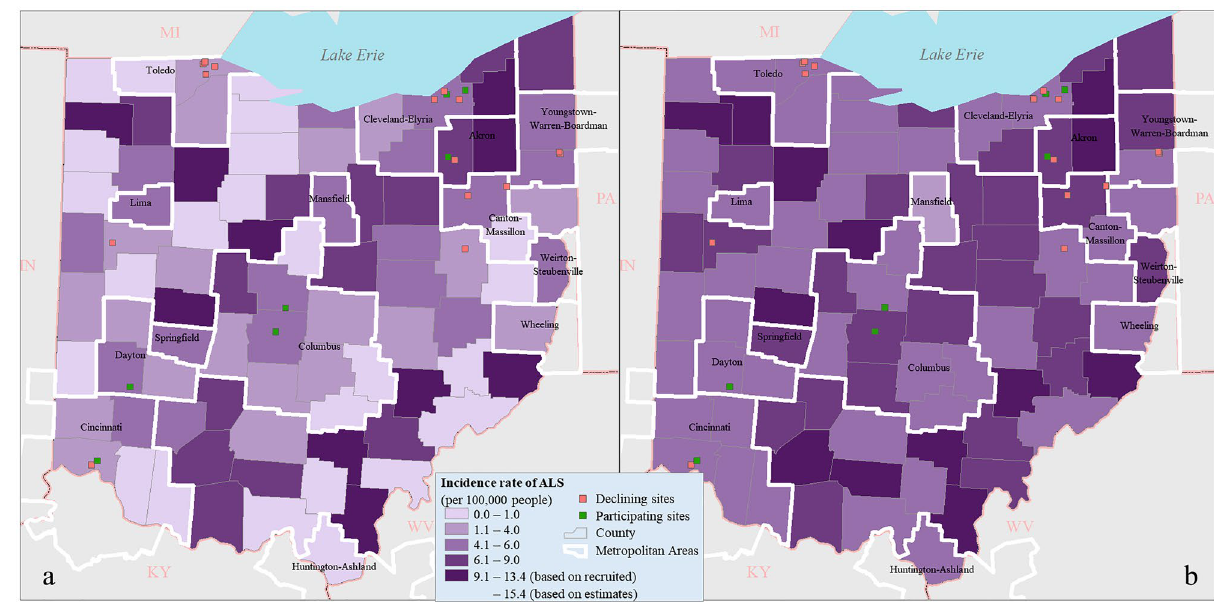
Figure 2. The incidence rate of ALS in Ohio. ( a ) Before including the estimated unrecruited cases; ( b ) after including the estimated unrecruited cases.